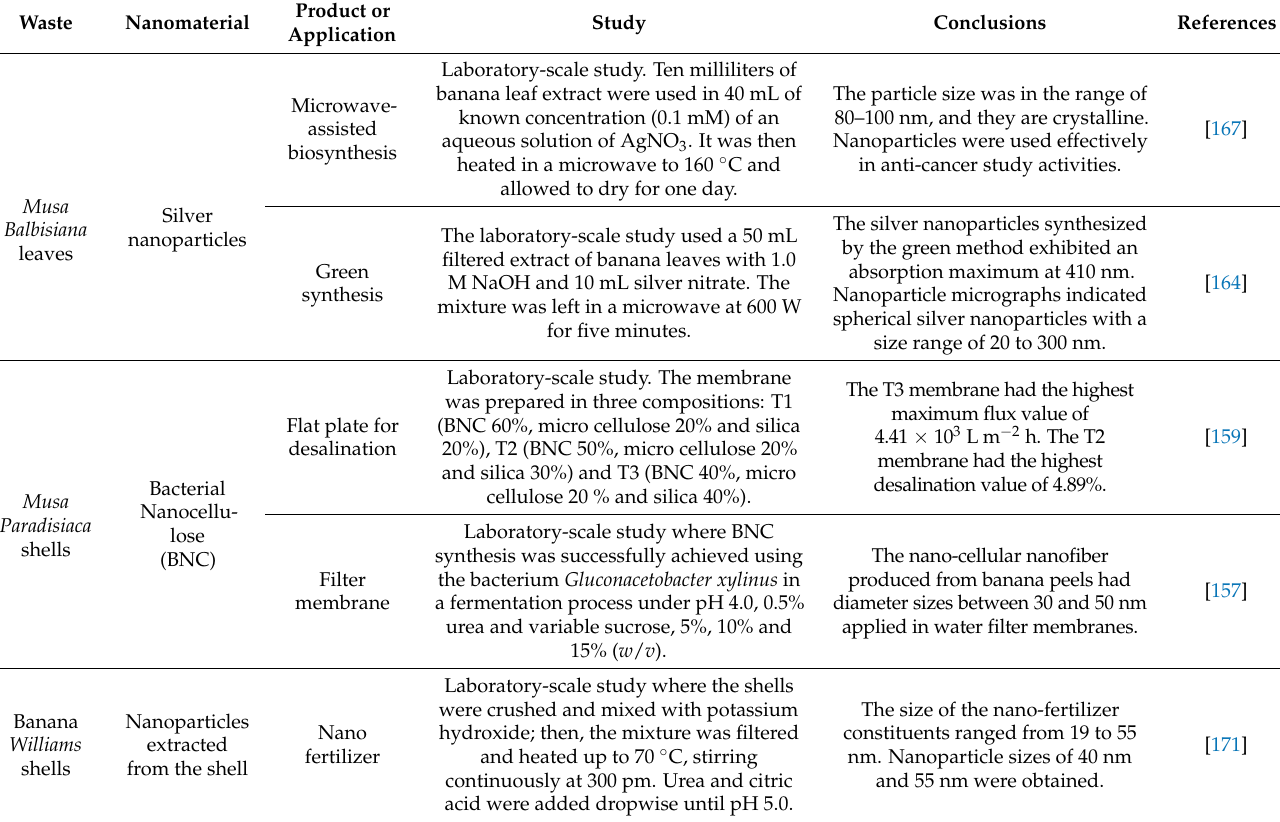
Table 9. Studies on the production and application of nanomaterials from banana processing waste-loss. Product or Waste Nanomaterial Application